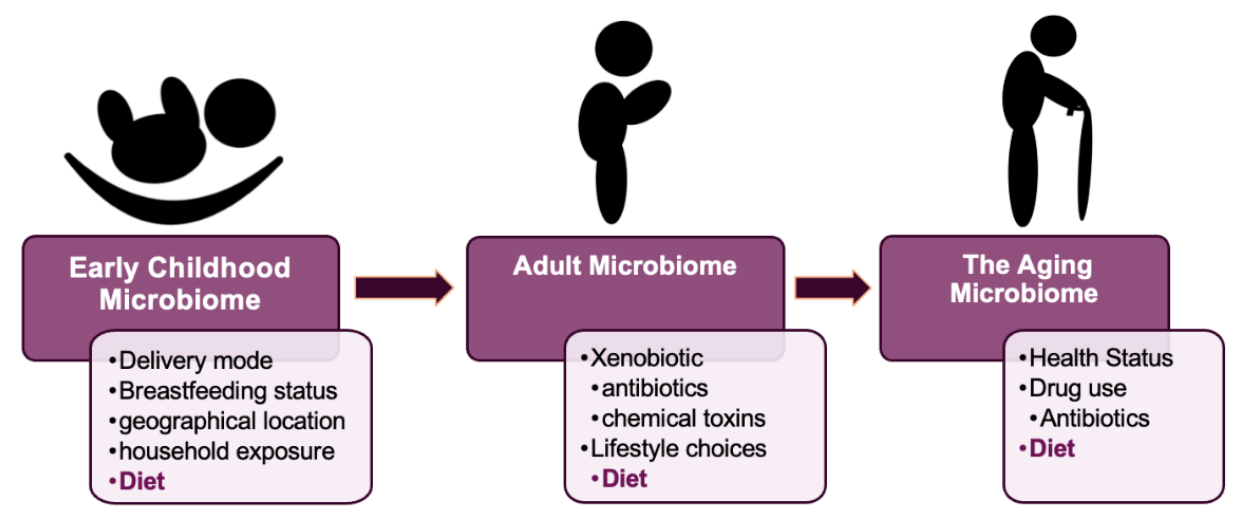
Figure 1. Factors affecting gut microbiota development through life .